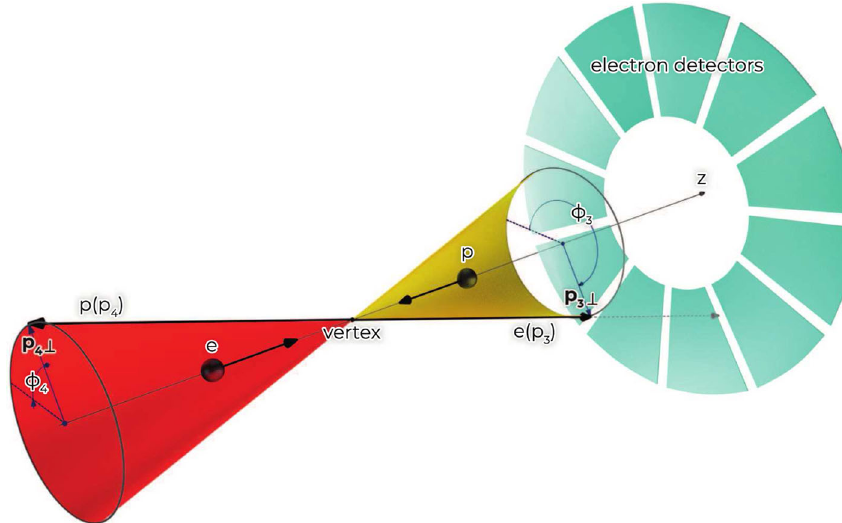
“which-way” experiment with elastic ep → ep scattering. The proton becomes twisted if the electron azimuthal angle φ 3 is measured with a large uncertainty σ φ → 2 π or is not measured at all. Instead of the proton, any other hadron, ion, or nucleus can be